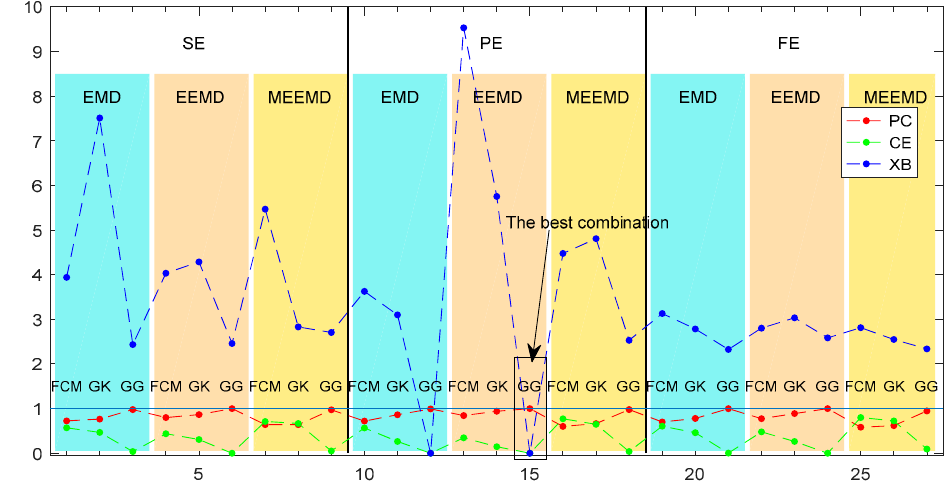
Figure 10. Clustering indicator for each type of fault diagnosis method.